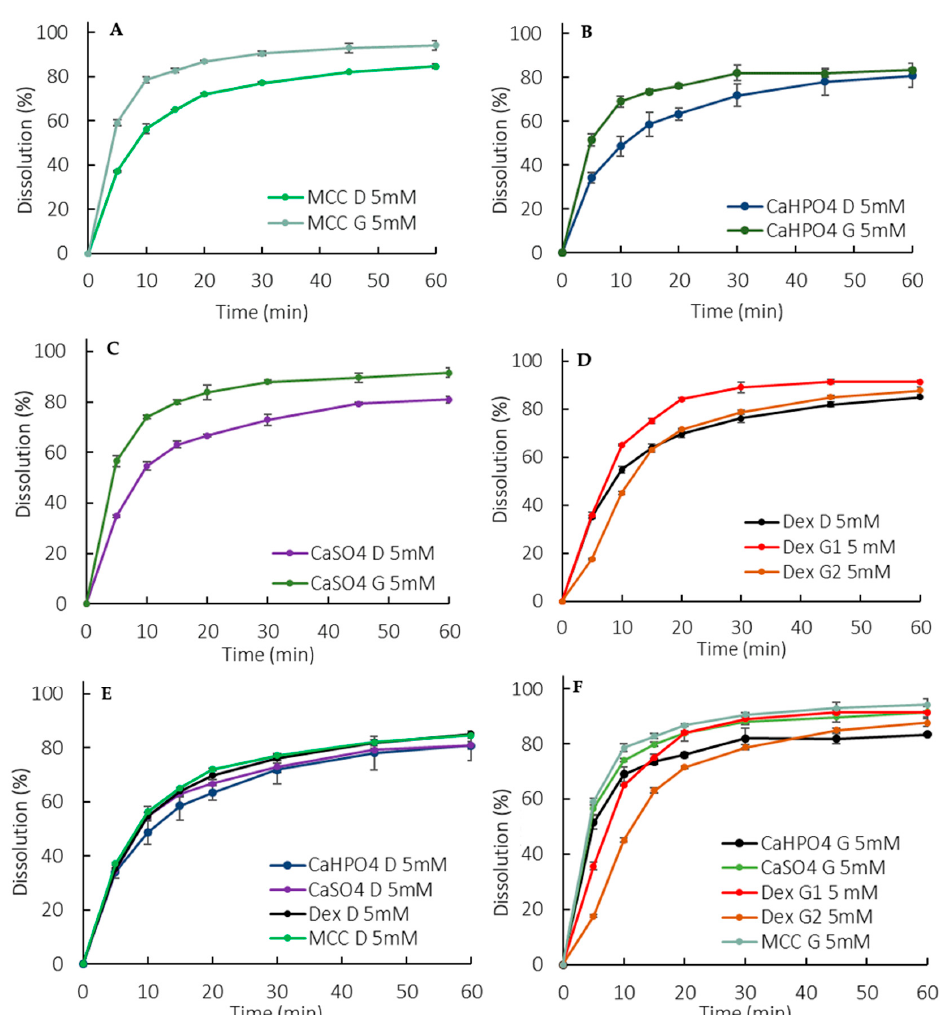
Figure 3. Dissolution profiles in the 5 mM phosphate buffer (900 mL). ( A ) MCC formulations, ( B ) CaHPO4 formulations, ( C ) CaSO 4 formulations, ( D ) Dextrose formulations, ( E ) D formulations, ( F ) G formulations. Error bars represent the standard deviation.